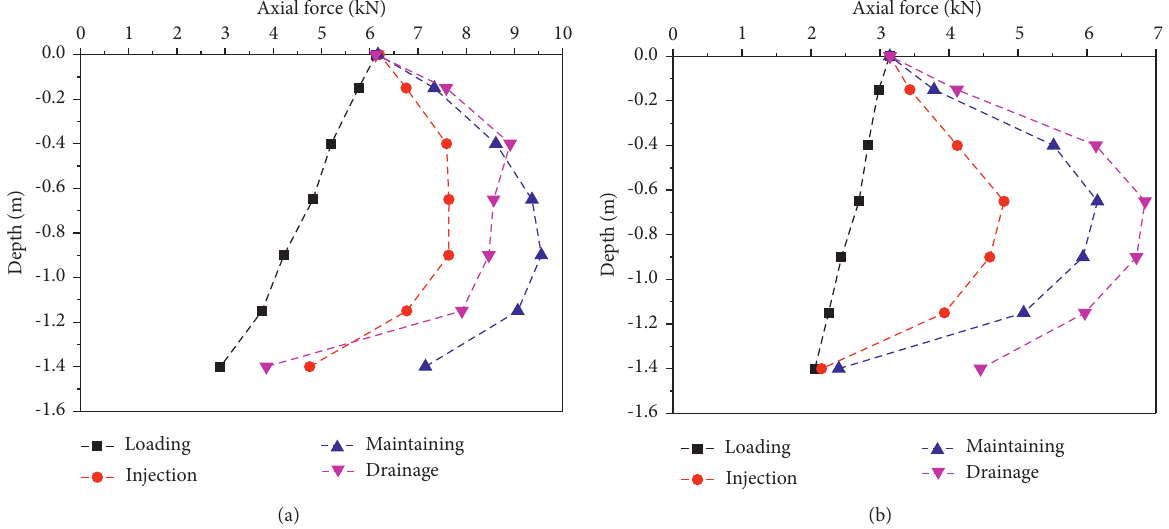
Figure 5: Average axial force distribution of piles in different test conditions. (a) Pile load: 12kN. (b) Pile load: 24kN.